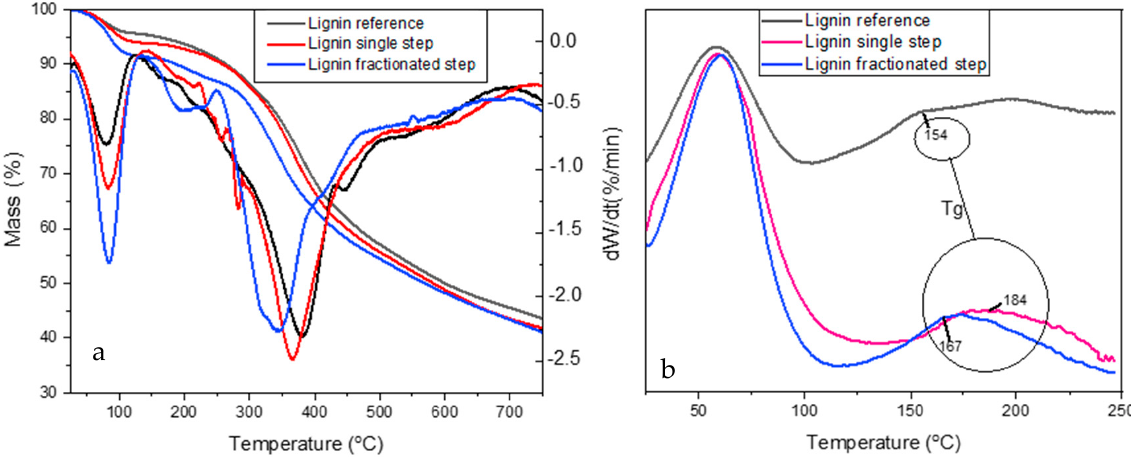
Figure 6. TGA ( a ) and DSC ( b ) thermogram of lignin standard, single-step lignin, and fractionated- step lignin.